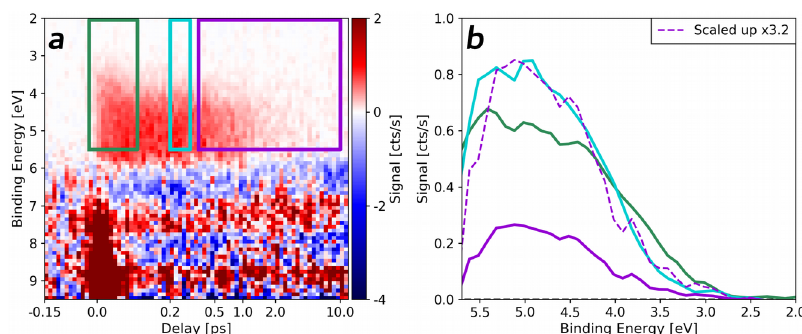
Figure 1: a) False color 2D difference map (the signal at negative delays is used for subtraction) of time-resolved photoelectron spectra of Methyl Orange in aqueous solution. Red color corresponds to signals enhanced by the 400 nm pump pulse, while blue colors correspond to depletion. The strong enhancement of the signal around zero time corresponds to liqht-assisted photoionization of water molecules, while the weaker band at low binding energies (3-6 eV) reflects electronic relaxation of the molecule. b) Averaged transient photoelectron spectra extracted from the map in part a) (see colored boxes). At early time delays the spectrum shifts to higher binding energies, while at later delays the excited state signals decay without further spectral